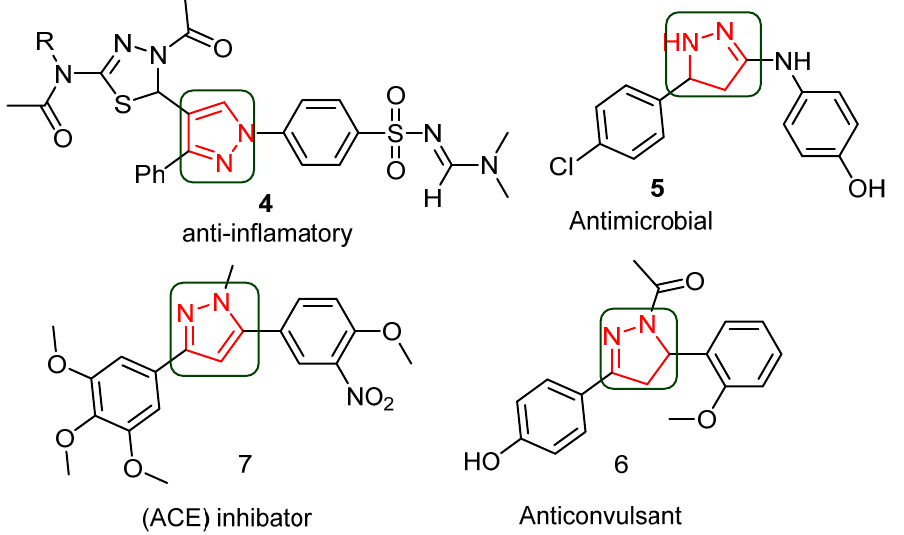
Figure 2. Pyrazoles as anti-inflammatory antimicrobial and anticonvulsant activities.